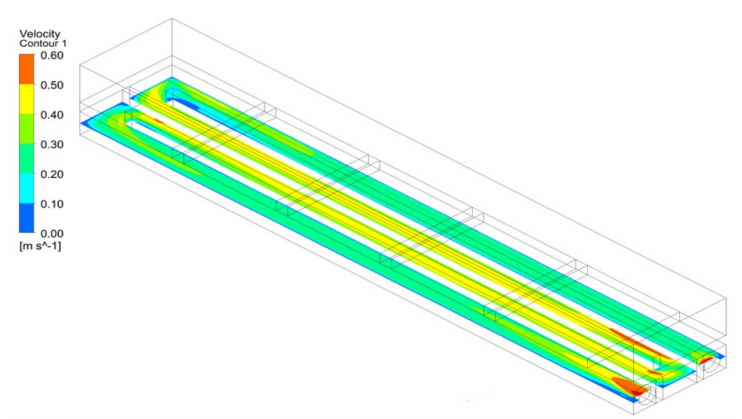
Figure 15. Flow velocity